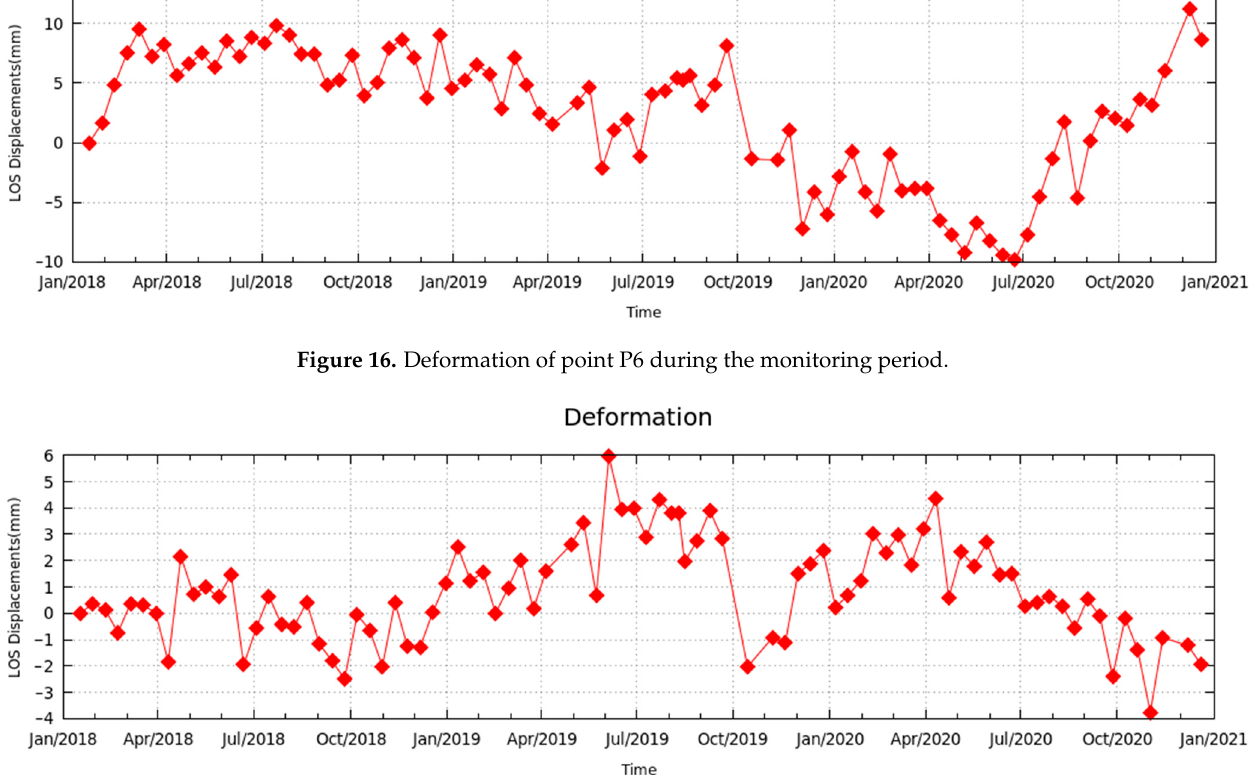
Figure 17. Deformation of point P7 during the monitoring period.